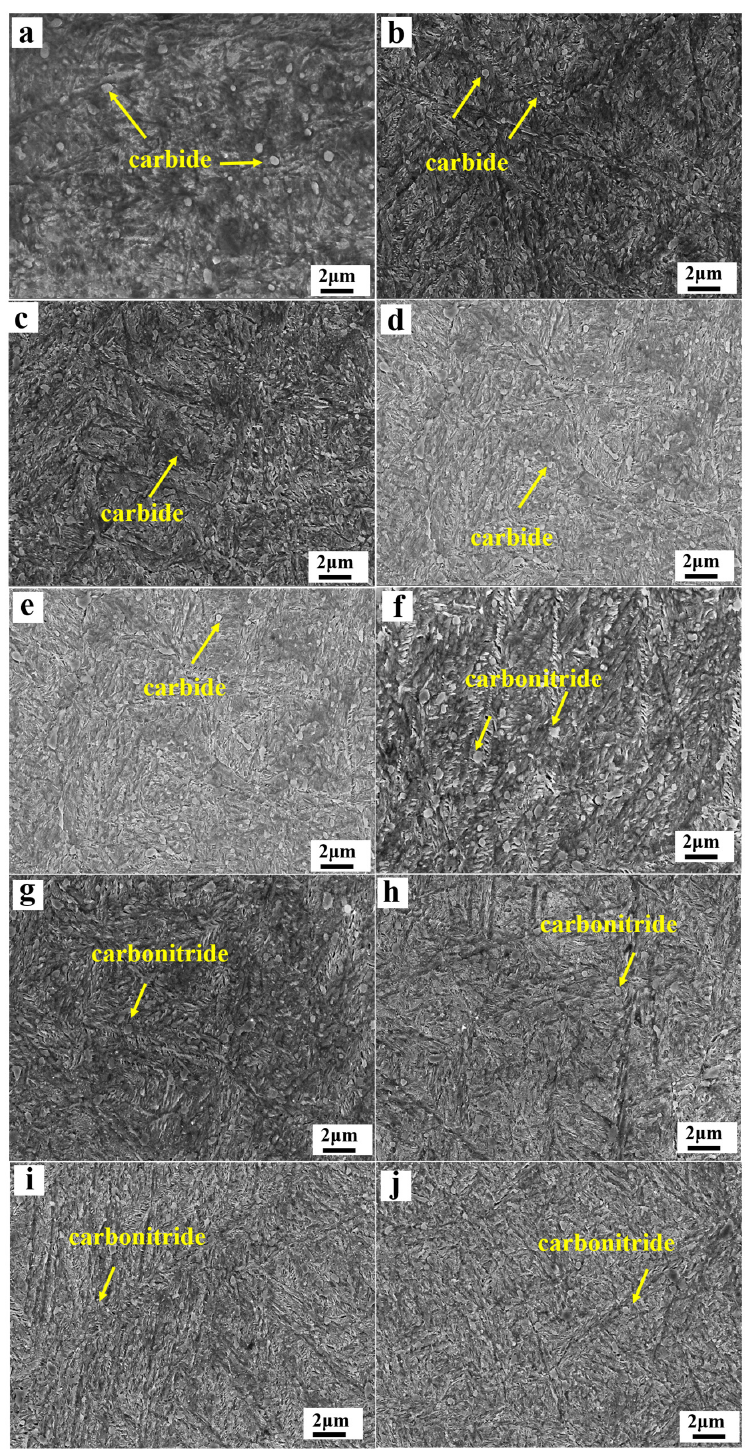
Figure 12. Precipitates of modi fi ed layer ( a ) Microstructure of the surface layer in the C state; ( b ) microstructure of the C state at 50 µm from the surface; ( c ) microstructure of the C state at 100 µm from the surface; ( d ) microstructure of the C state at 150 µm from the surface; ( e ) microstructure of the C state at 200 µm from the surface; ( f ) microstructure of the surface layer in the C + N state; ( g ) microstructure of the C + N state at 50 µm from the surface microstructure; ( h ) microstructure of C + N state at 100 µm from the surface; ( i ) microstructure of C + N state at 150 µm from the surface; (j) microstructure of C + N state at 200 µm from the surface.